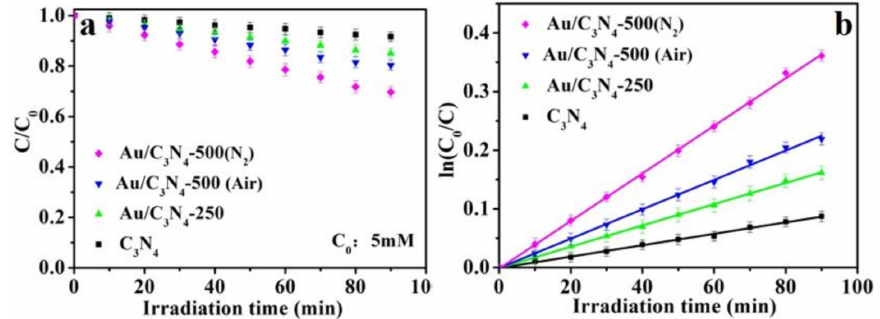
Figure 6. The photocatalytic decomposition of H 2 O 2 (C 0 = 5 mM) on the C 3 N 4 , Au/C 3 N 4 -250, Au/C 3 N 4 -500(Air), and Au/C 3 N 4 -500(N 2 ). ( a ) The changes of C/C 0 with irradiation time; ( b ) The changes of ln(C/C 0 ) with irradiation time. The experimental conditions: 1 g/L of photocatalyst, pH 3.0, Xe lamp, and illumination intensity of 100 mW/cm 2 .